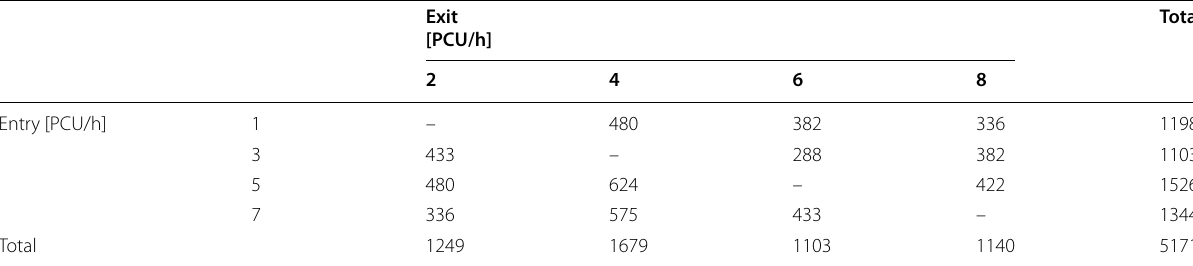
Table 4 Entry-exit matrix of the OD pairs for the network